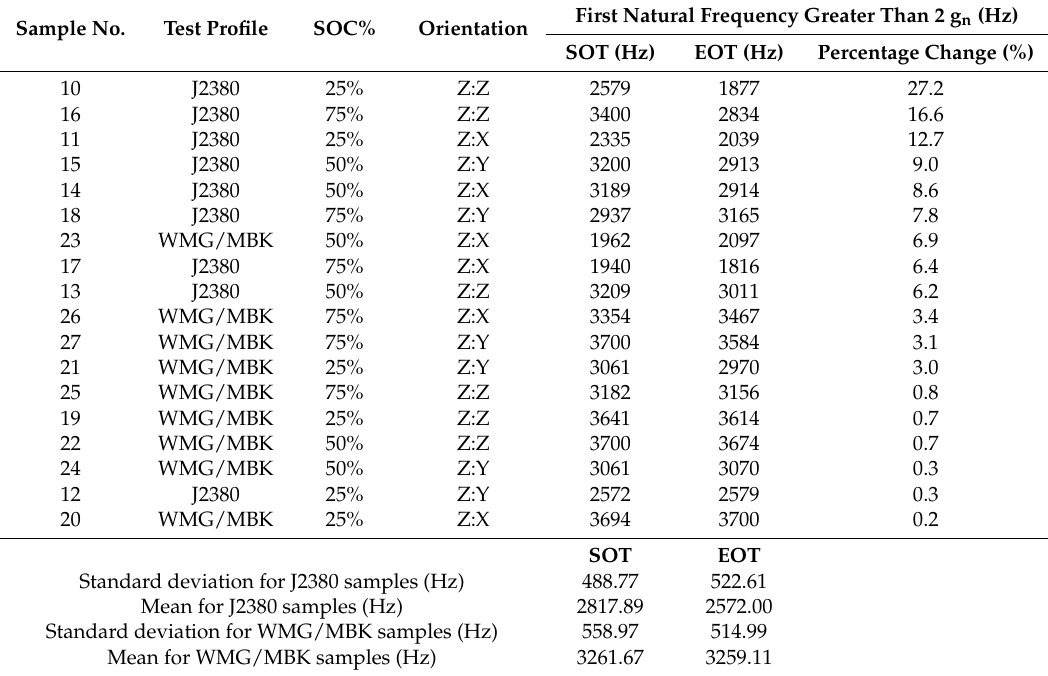
Table 5. Summary of change in frequency of observed first cell resonance for all test samples. Sample